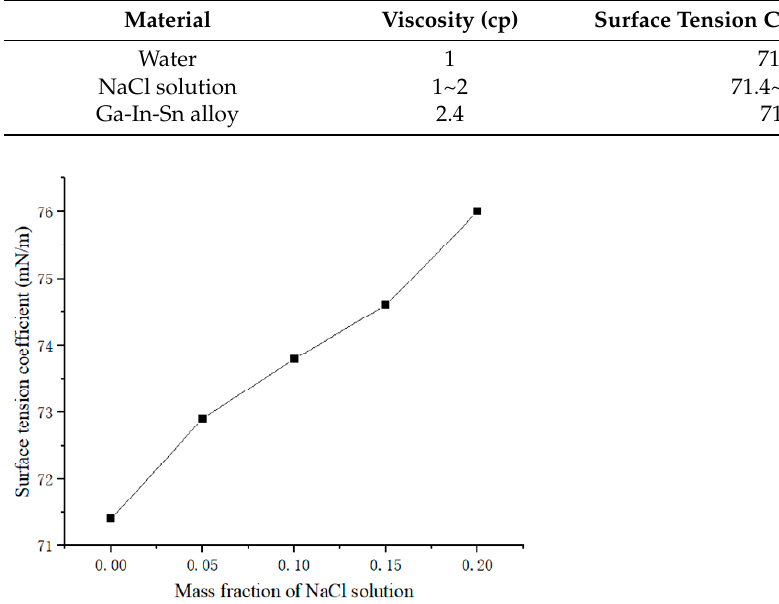
Table 1. Viscosity and surface tension coefficient of materials [51–56].